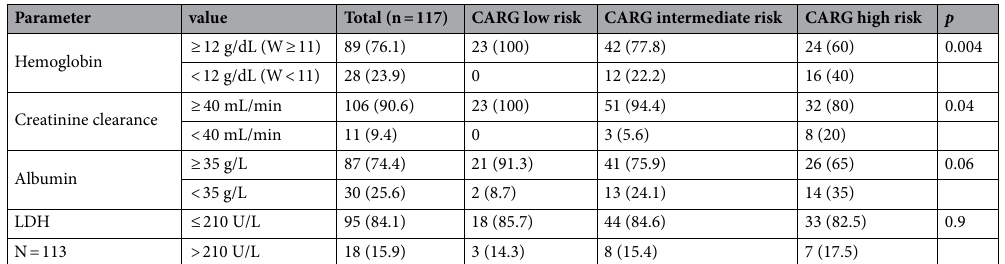
Table 5. Laboratory parameters in the groups according to CARG risk category. Percentages are in parentheses.